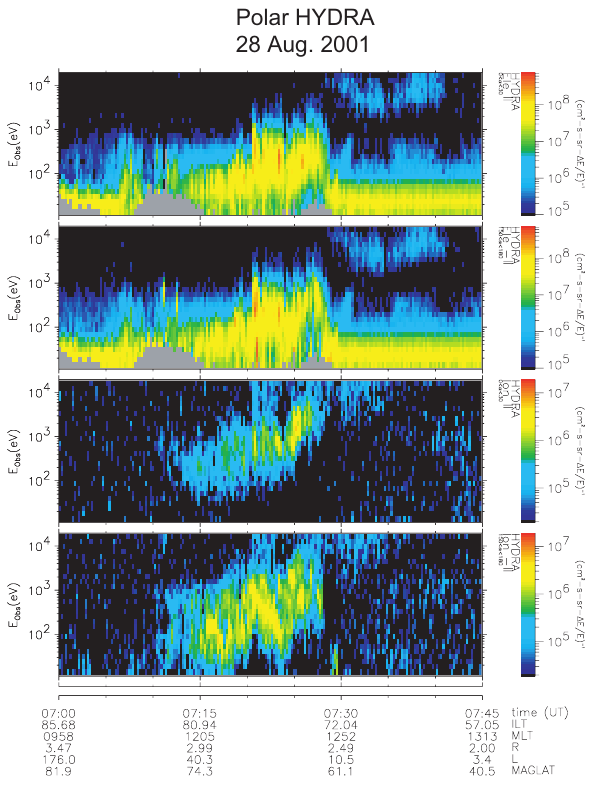
Fig. 3. Spectrogram of the Polar HYDRA electron and ion energy Figure 3 flux for the DSIV event of 28 August 2001. Beginning at the top, the panels shown are downward and upward electrons, and downward and upward ions. Inverted-V structures are observed in the interval from about 07:20 UT to 07:30 UT.